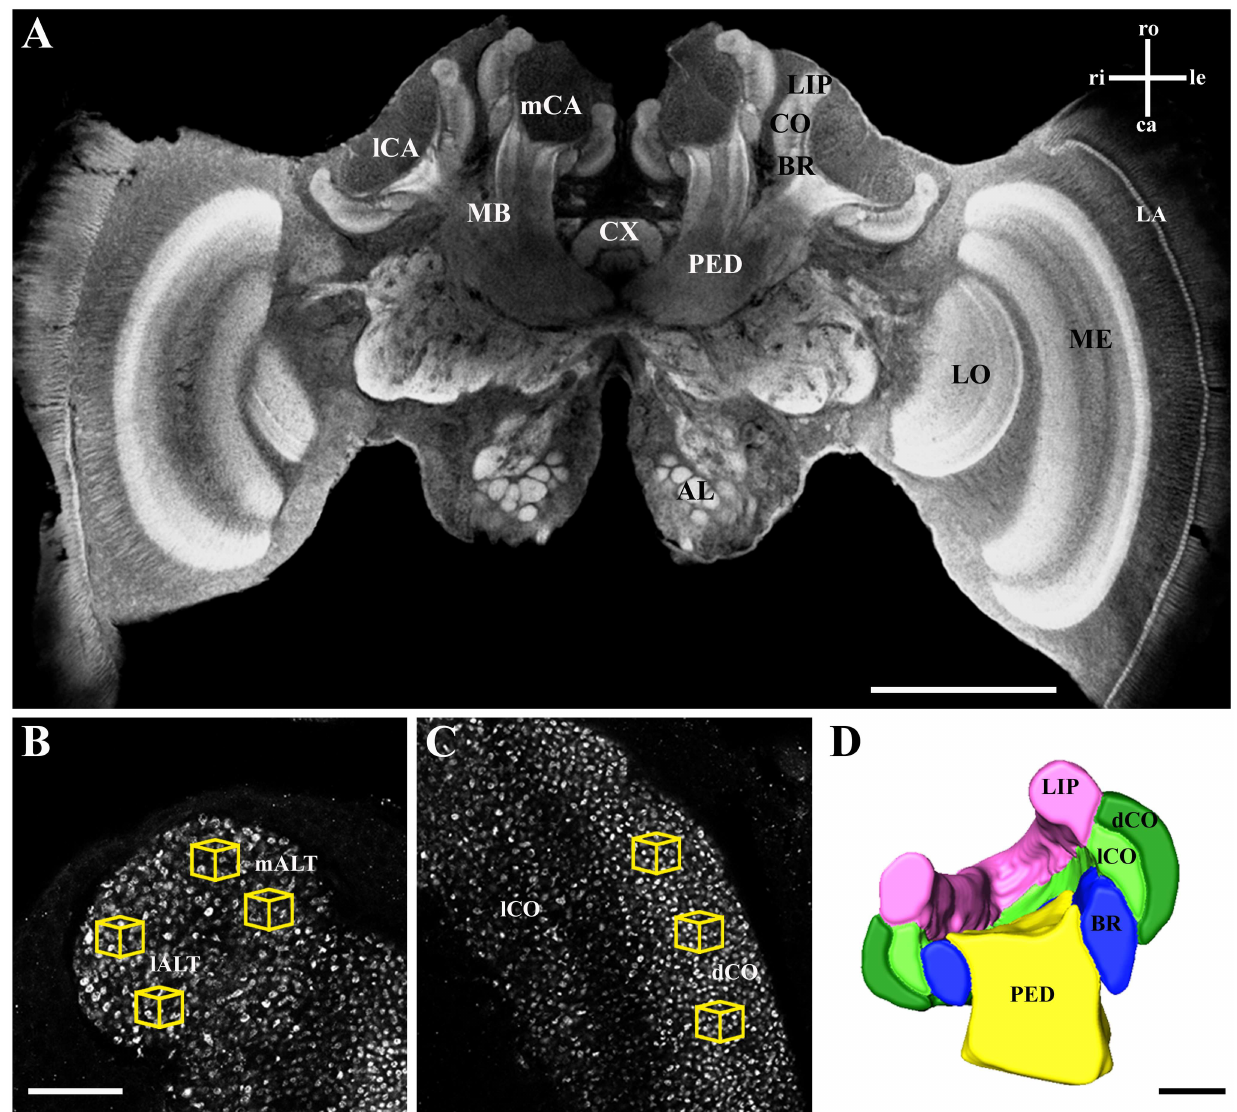
Fig 2. Synapsin immunostaining and 3D calyx reconstruction of a forager honeybee brain. A Confocal image of a frontal section through the brain after whole-mount immunolabeling for synapsin. Calyx volume and MG density were quantifiedin one of the medialcalyces (mCA). In the magnifiedview of the lip ( B ) and the collar ( C ), synapsin-labeledprojectionneuron boutons (MG) were counted in defined volumes (1000 μ m 3 ; yellow cubes) in three regions: mALT innervatedlip, lALT innervatedlip, and dense collar (dCO). D Cross section of the volume reconstruction of the mCA renderedfrom confocal image stacks. AL, antennallobe; BR, basal ring; mCA, medialcalyx; lCA, lateral calyx; CX, central complex; dCO, dense collar; lCO, loose collar; LA, lamina; LO, lobula; MB, mushroom body; ME, medulla; PED, peduncle. Axes: ca, caudal; le, left; ri, right; ro, rostral. Scale bar in A is 500 μ m, in B (and C ) 25 μ m, and in D 100 μ